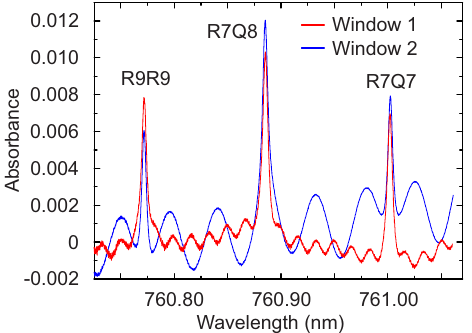
Figure 8. Typical absorbance for the three lines R9R9 (760.77 nm), R7Q8 (760.89 nm) and R7R7 (761.003 nm) of the O 2 near infrared A-band. Superimposed to the absorption features are the interferences caused by the window 1 (d = 11 mm) and window 2 (d = 4 mm). The measurement is taken at atmospheric conditions.